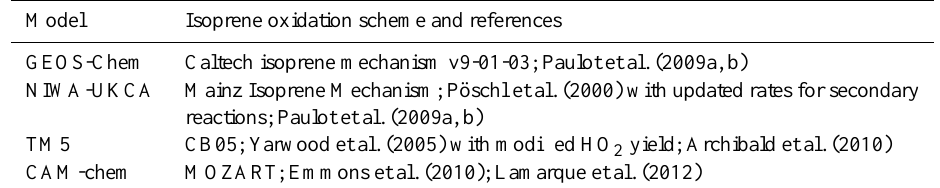
Table 4. Isoprene oxidation mechanisms in SHMIP